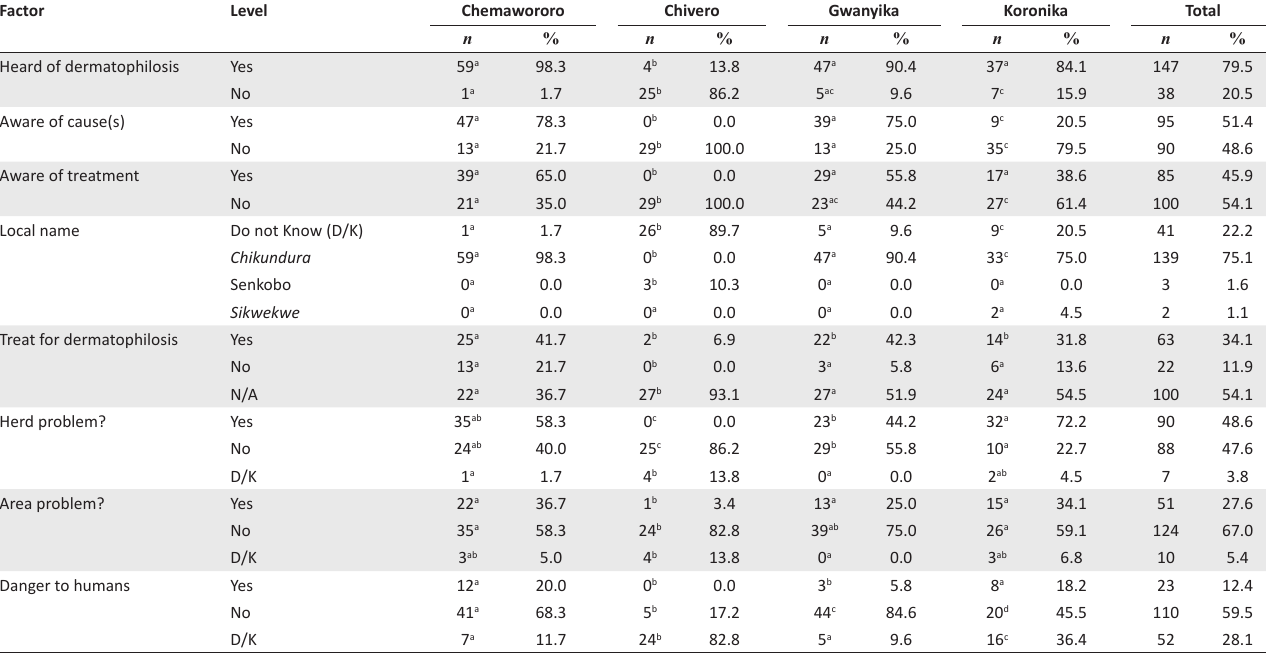
TABLE 2: Stockowners’ knowledge and perceptions about bovine dermatophilosis according to diptank. Factor